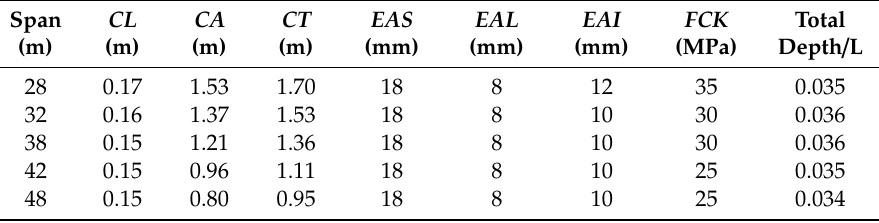
Table 7. GSO with DLS combination for 28, 32, 38, 42, and 48 m spans.